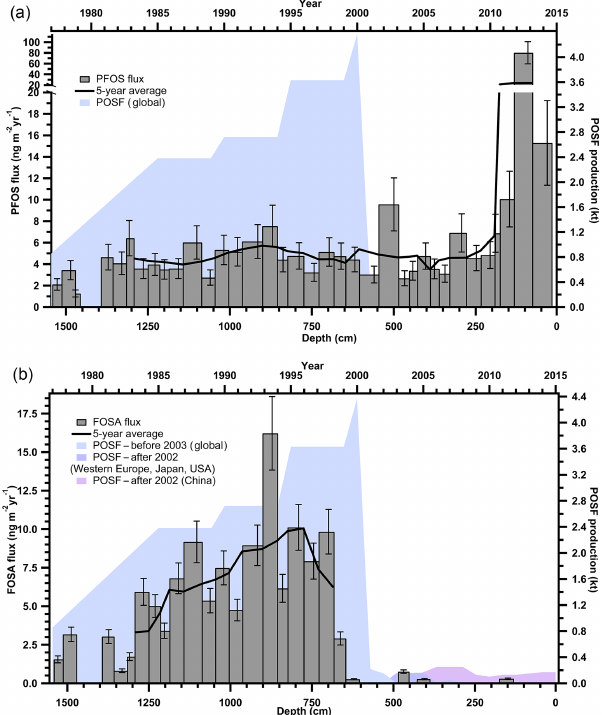
Figure 3. Annual deposition fluxes on the Devon Ice Cap: (a) PFOS and (b) FOSA, with global POSF production from 1977 to 2003 and POSF production for Western Europe, Japan, United States and China from 2003 to 2015 (Wang et al., 2014a, 2017). Solid black lines represent 5-year moving